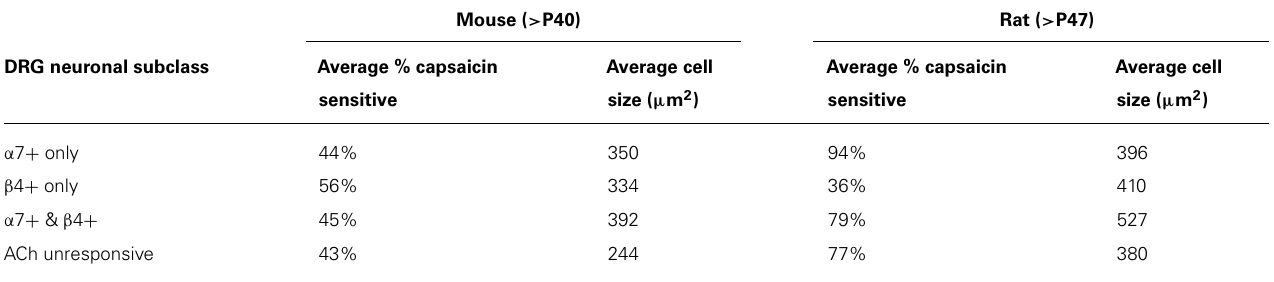
Table 3 |Average percentages of neurons responsive to 300 nM capsaicin and their average cross-sectional cell areas (cell size) within different mature DRG neuronal subclasses defined by functional nAChR